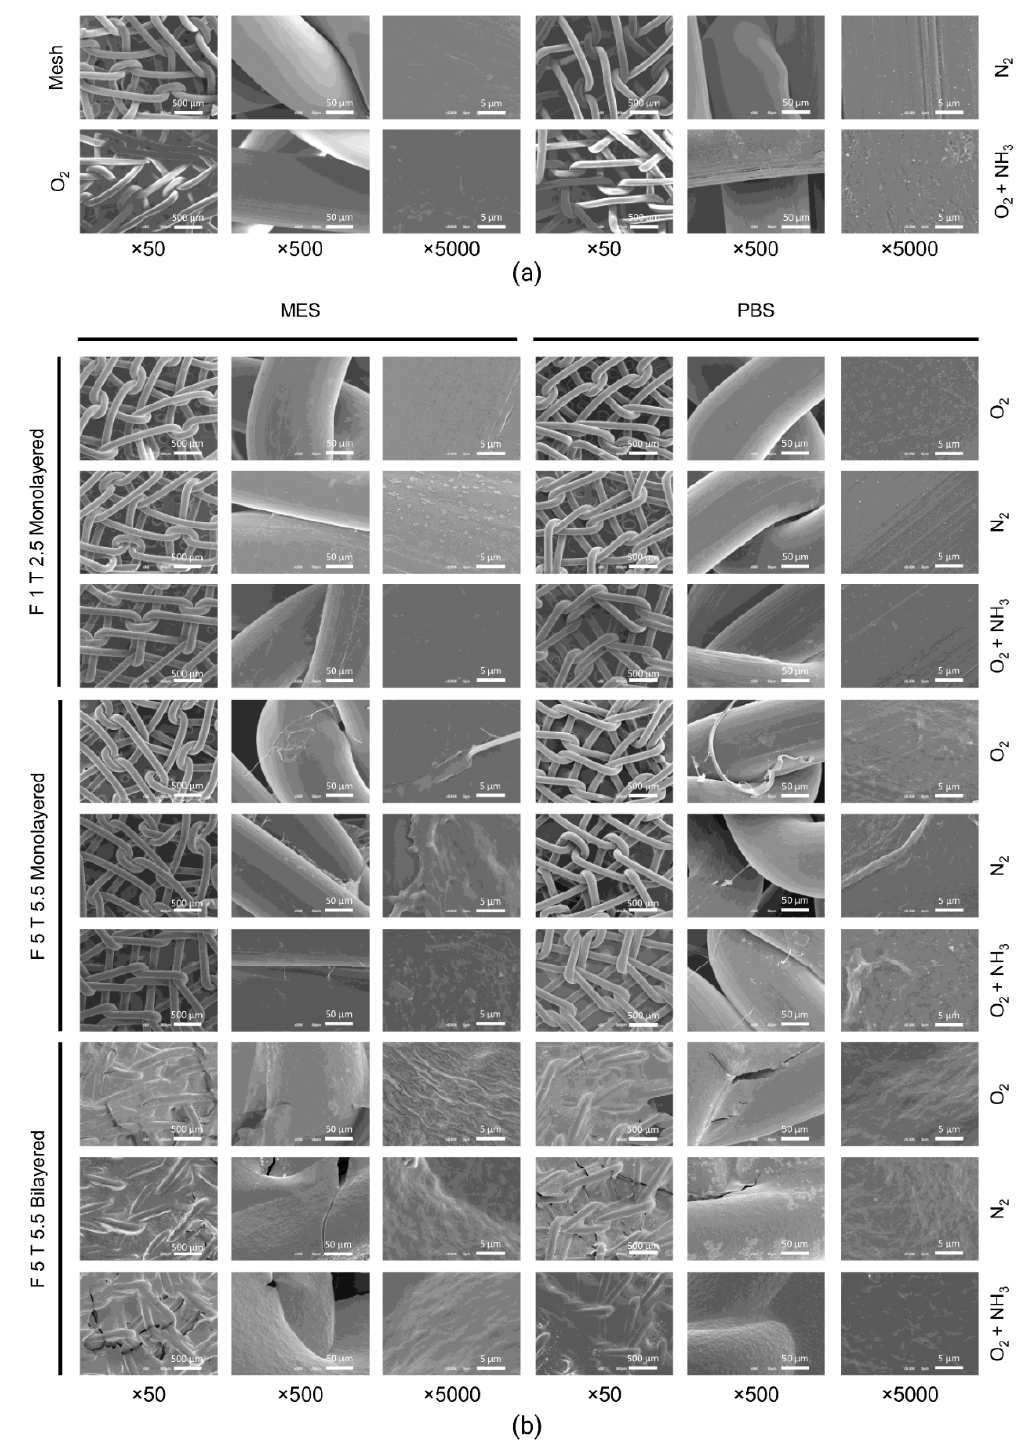
Figure 1. SEM micrographs of fibrin-coated surgical meshes with plasma treatment. ( a ) PP surgical meshes were treated with plasma (oxygen or nitrogen) and some of the oxygen plasma-treated meshes were immersed in ammonia. ( b ) Monolayered or bilayered fibrin coatings were performed with fibrinogen (F) and thrombin (T) from Tisseel ® (Baxter) in MES (2-(N-morpholino)ethanesulfonic acid buffered saline) or in PBS (phosphate-buffered saline) on plasma-treated meshes (oxygen, nitrogen or oxygen plasma-treated meshes immersed in ammonia). × 50, × 500, and × 5000 magnifications are shown. Fibrinogen and thrombin concentrations are expressed in mg/mL and IU (international units)/mL, respectively. F 1: fibrinogen 1 mg/mL; F 5: fibrinogen 1 mg/mL; N 2 , nitrogen plasma; O 2 , oxygen plasma; O 2 + NH 3 , oxygen plasma + ammonia treatment; T 2.5: thrombin 2.5 IU/mL; T 5.5: thrombin 5.5 IU/mL.